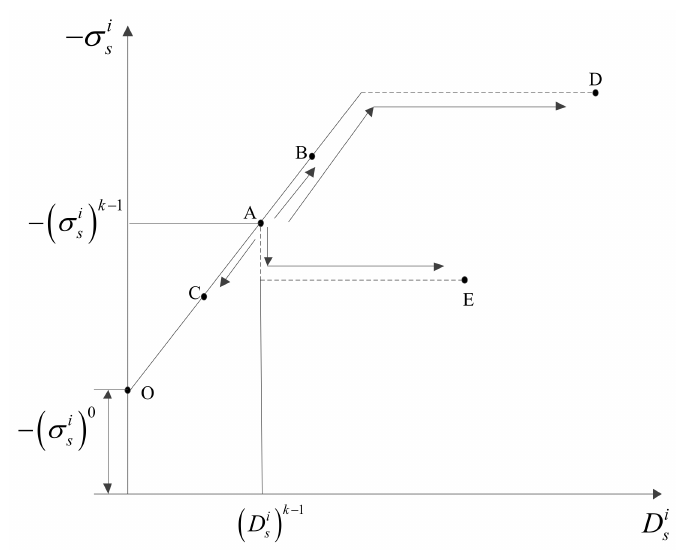
Figure 4. The curve of shear stress and shear